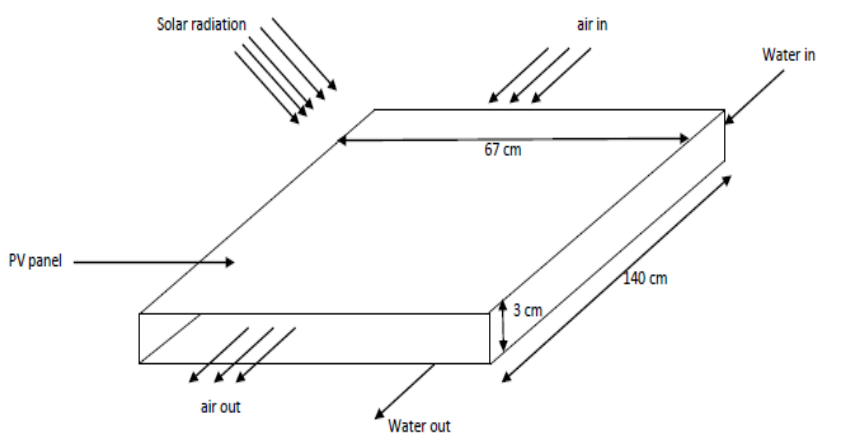
Figure 1. Schematic diagram for the photovoltaic (PV) panel with evaporative cooling.